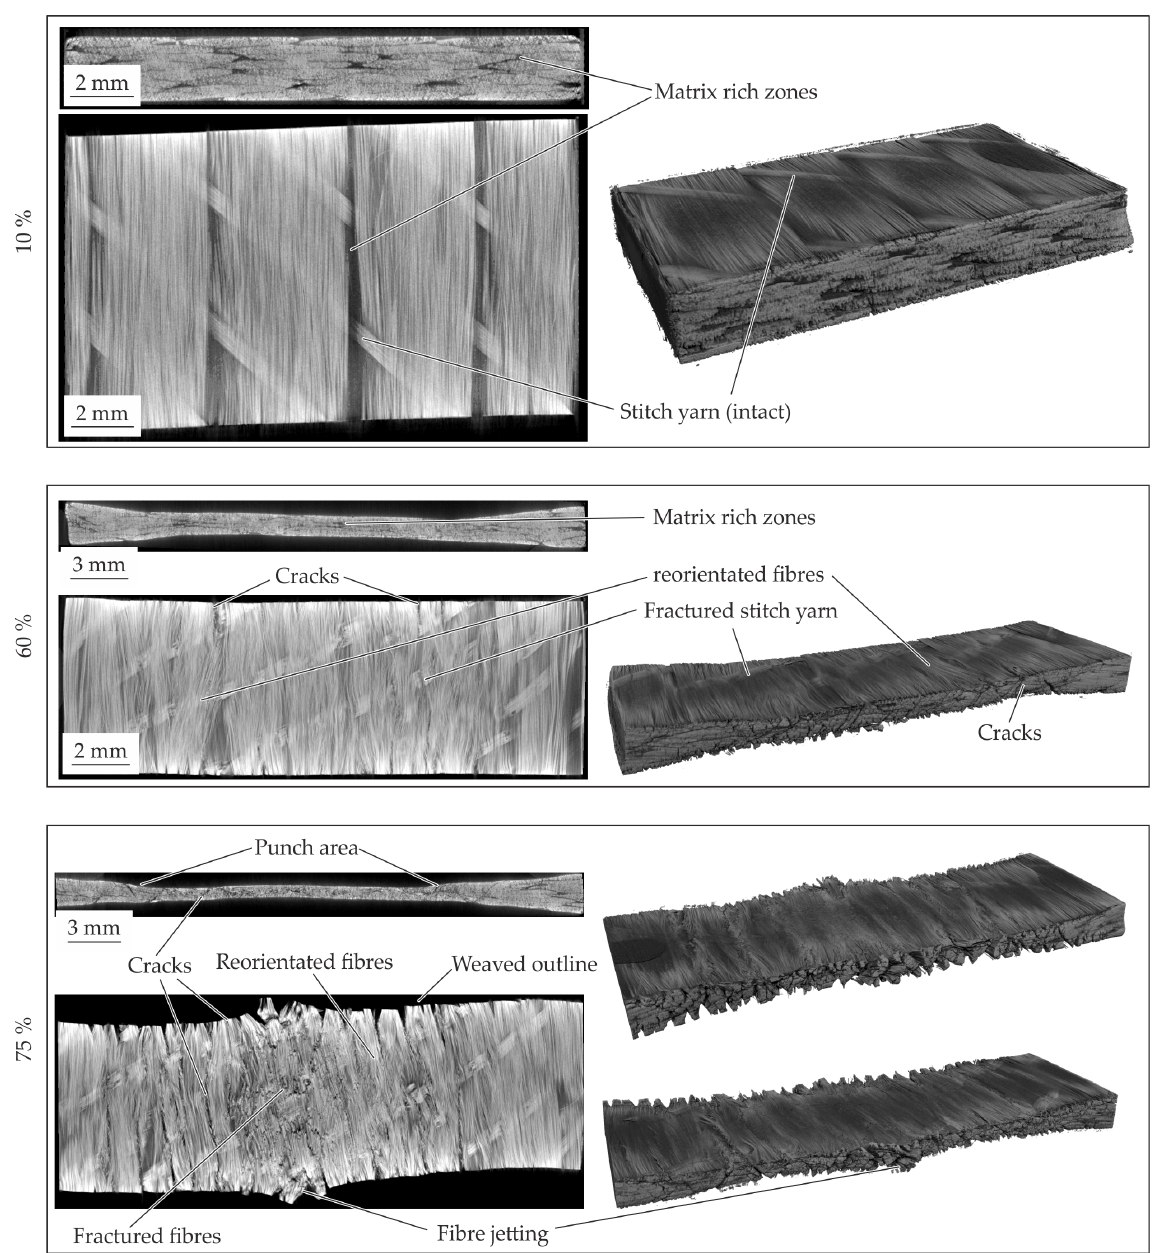
Figure 12. CT analysis of the 2mm—configuration for the different compaction levels at